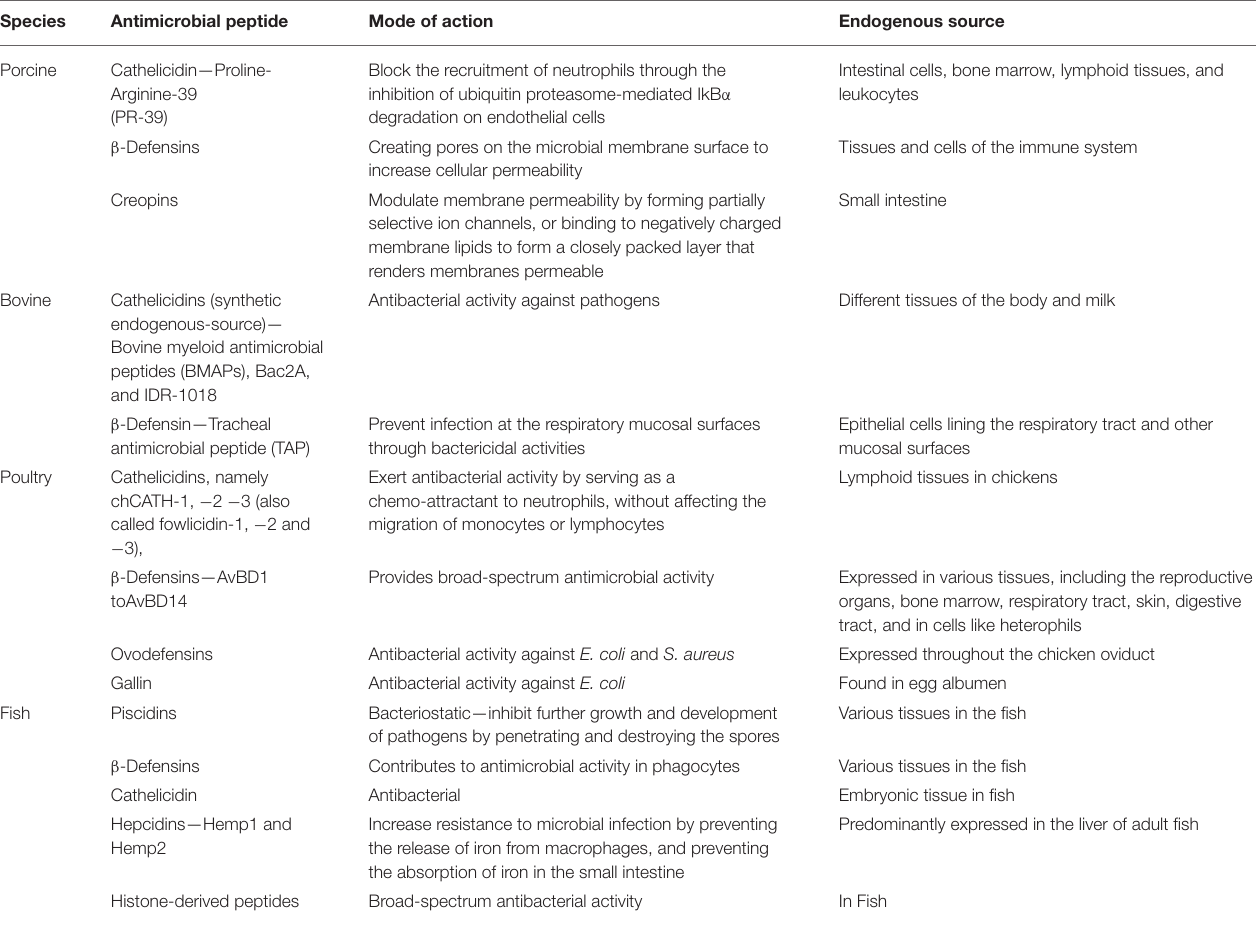
TABLE 1 | Endogenous antimicrobial peptides in food animals.